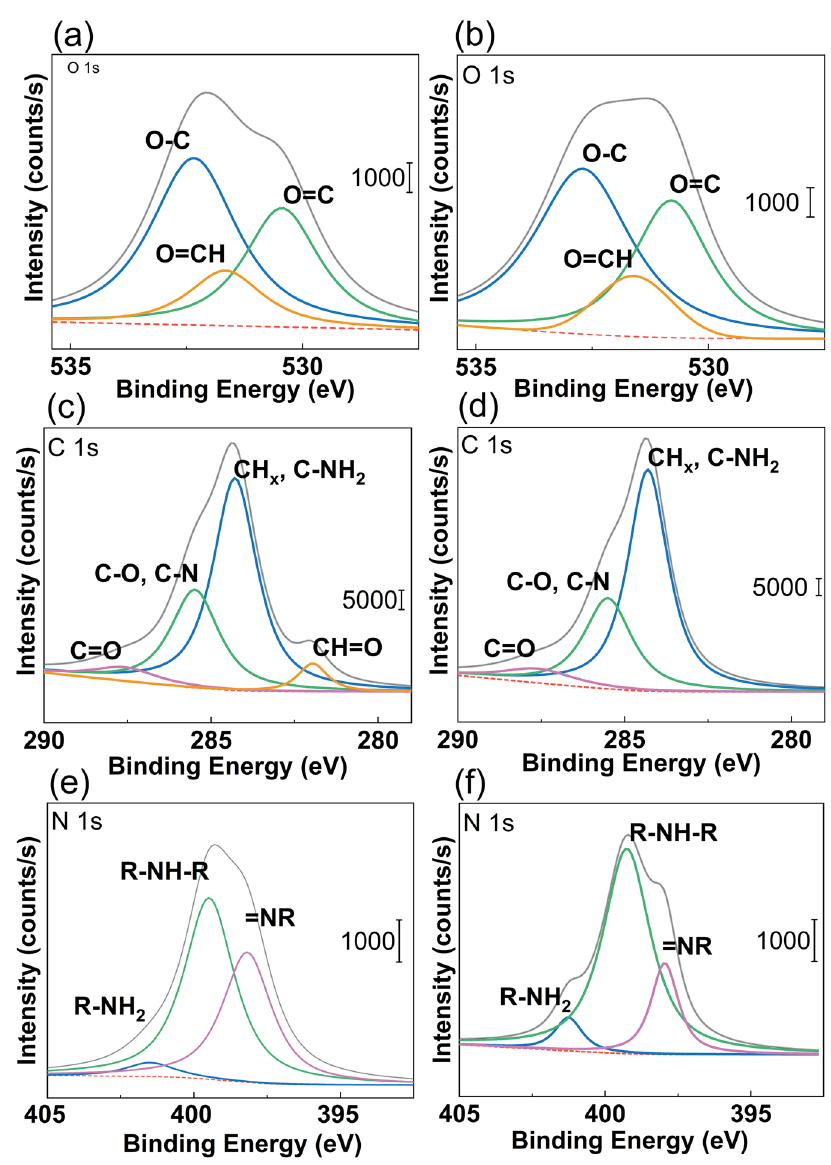
Fig. 7 Binding energies of ( a , b ) O 1s, ( c , d ) C 1s ( e , f ) N 1s on the linked-PDA surface from (left) EL1 and (right)